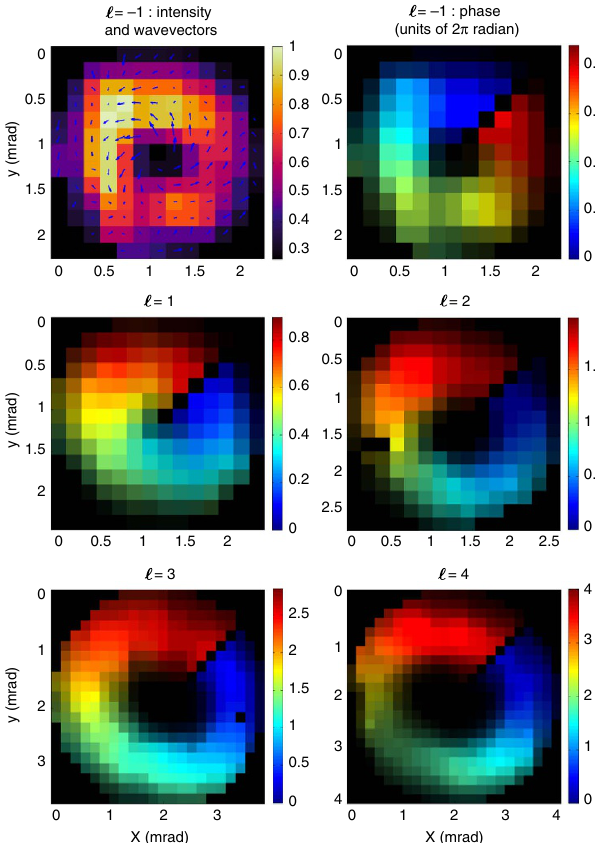
Figure 3 | Intensity and wavefront measurements for several modes carrying various topological charges. The top-left panel shows the intensity (in arbitrary units) and the local wavevector (arrows) distribution for the c ¼ (cid:2) 1 mode of the 16th high-harmonic order emission (h16). The other panels show the measured wavefronts for c ¼ (cid:2) 1 and c ¼ 1 for h16, c ¼ 2 for h19, c ¼ 3 for h18 and c ¼ 4 for h19 (intensity and wavevector distribution for the latter cases is shown in Supplementary Fig. 1). The intensity is represented by the brightness and the phase (in units of 2 p radian) by false colours. Black colour indicates pixels that contain no data (intensity lower than the detection threshold or pixels set to zero to enable wavefront reconstruction around the singularity). Note that the different panels have different colour scales. The yield of each individual mode was optimized (see next section), and a crossing angle of 15mrad was used to guarantee a larger spatial separation between the modes, compared to the one in Fig.